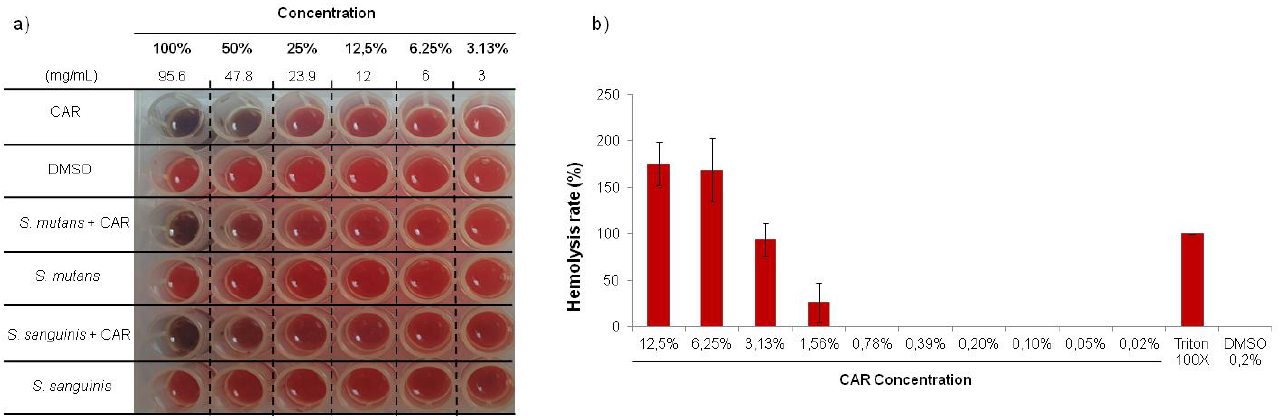
Figure 7. Hemolytic effect of different concentrations of CAR and solvent (DMSO) in the presence and absence of the strains studied in microtiter plate ( a ); Hemolysis rate ( b